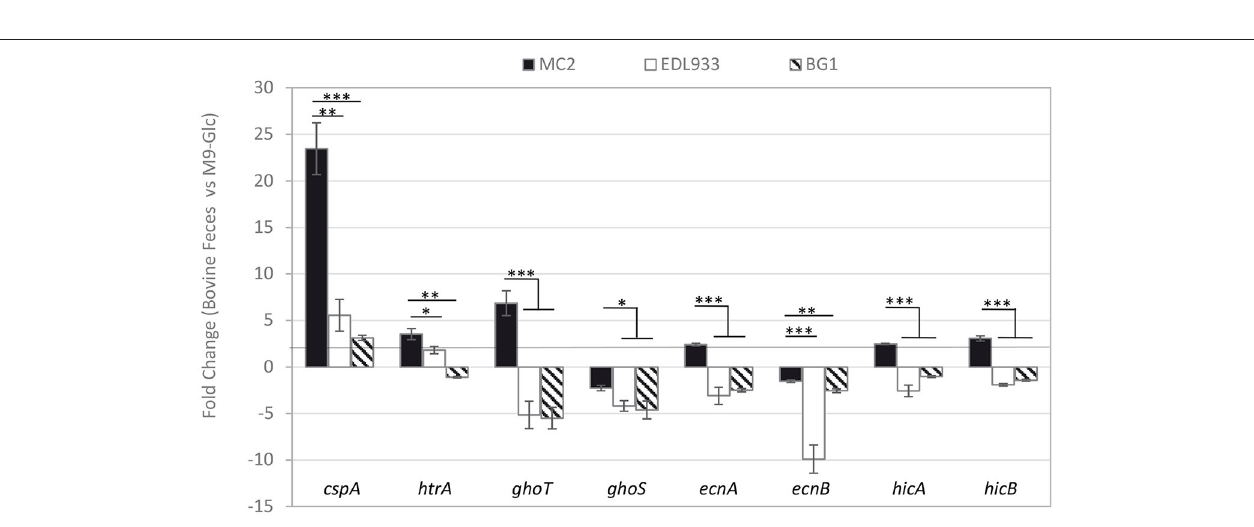
FIGURE 5 | Relative expression levels of stress fitness genes during incubation of E. coli O157:H7 MC2 and EDL933, and bovine commensal E. coli BG1 in filtered bovine feces in comparison with M9-Glc. Results are average fold changes in expression, with SEM from at least three independent values. * p < 0.05; ** p < 0.01; *** p <